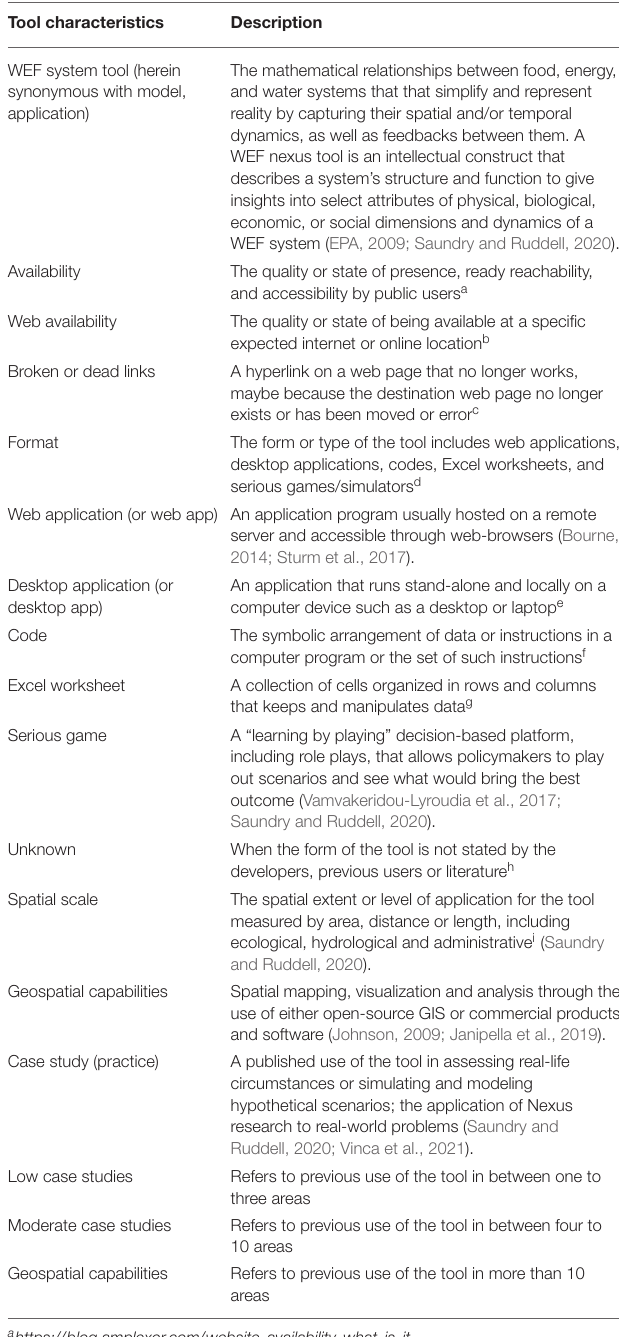
TABLE 1 | The adapted PICOS strategy used for literature searching.